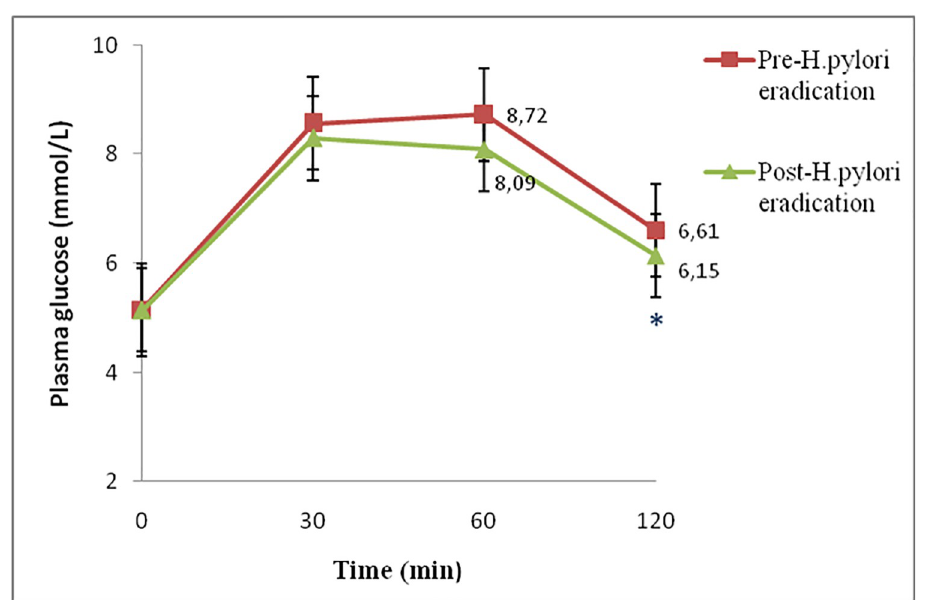
Fig 1. Glucose tolerance curve in patients before and after H . pylori eradication. The asterisks indicate p < 0.05. Glucose values (mmol/L) are shown for p <